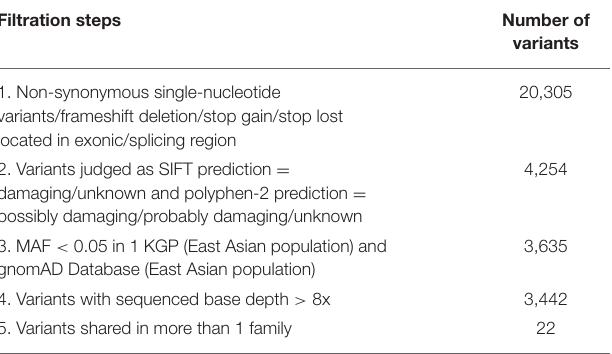
TABLE 2 | Variant filtration steps of whole exome